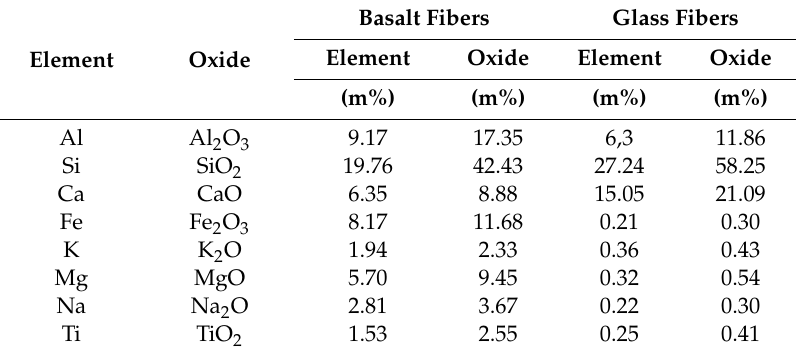
Table 2. Chemical composition of basalt and glass fibers [29].